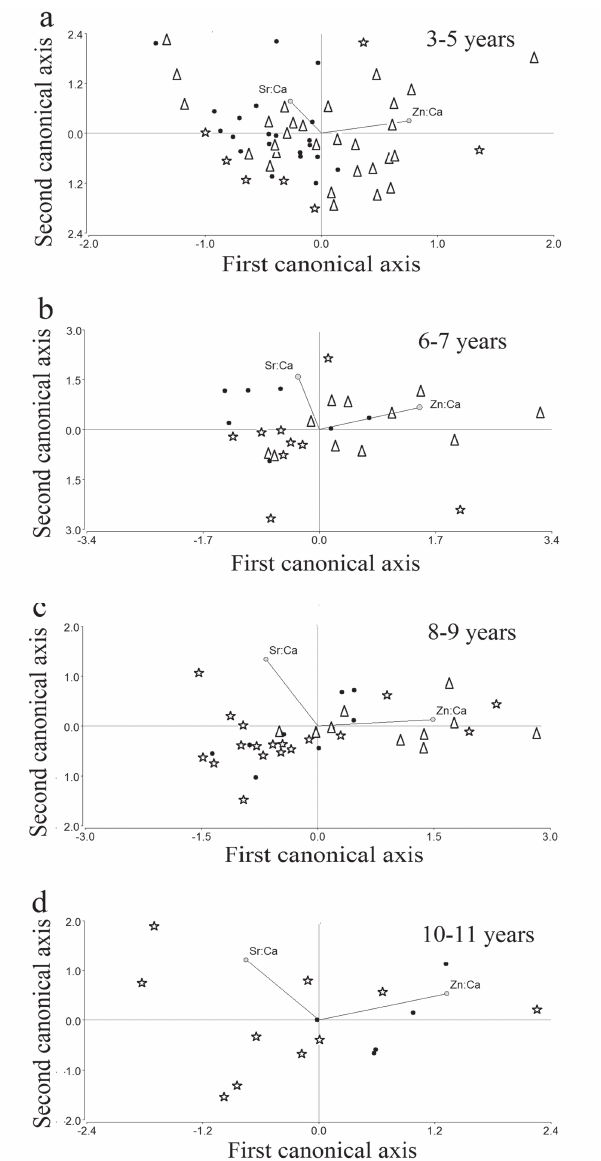
Fig. 4. Discriminant analysis of the otolith Sr:Ca and Zn:Ca ratios for Percophis brasiliensis . Plot of the first two discriminant functions for each age group (a-d). An association was observed between data for ER and SMG, which were separated from data for AUCFZ. Triangles: Argentine- Uruguayan Common Fishing Zone (AUCFZ), stars: San Matías Gulf (SMG) and black circles: El Rincón